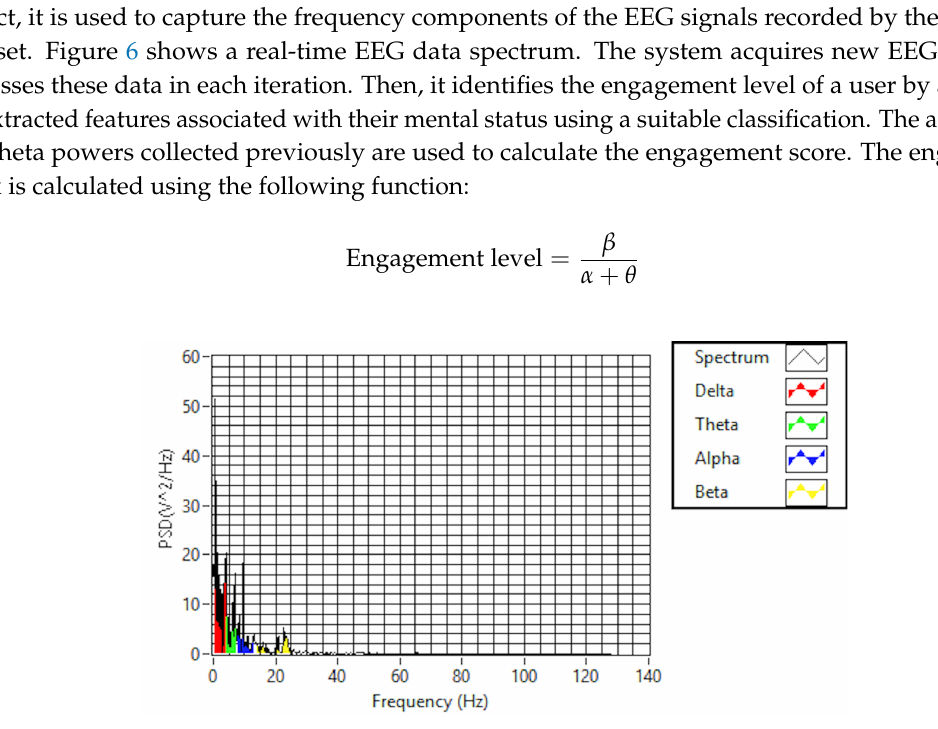
Figure 6. EEG data